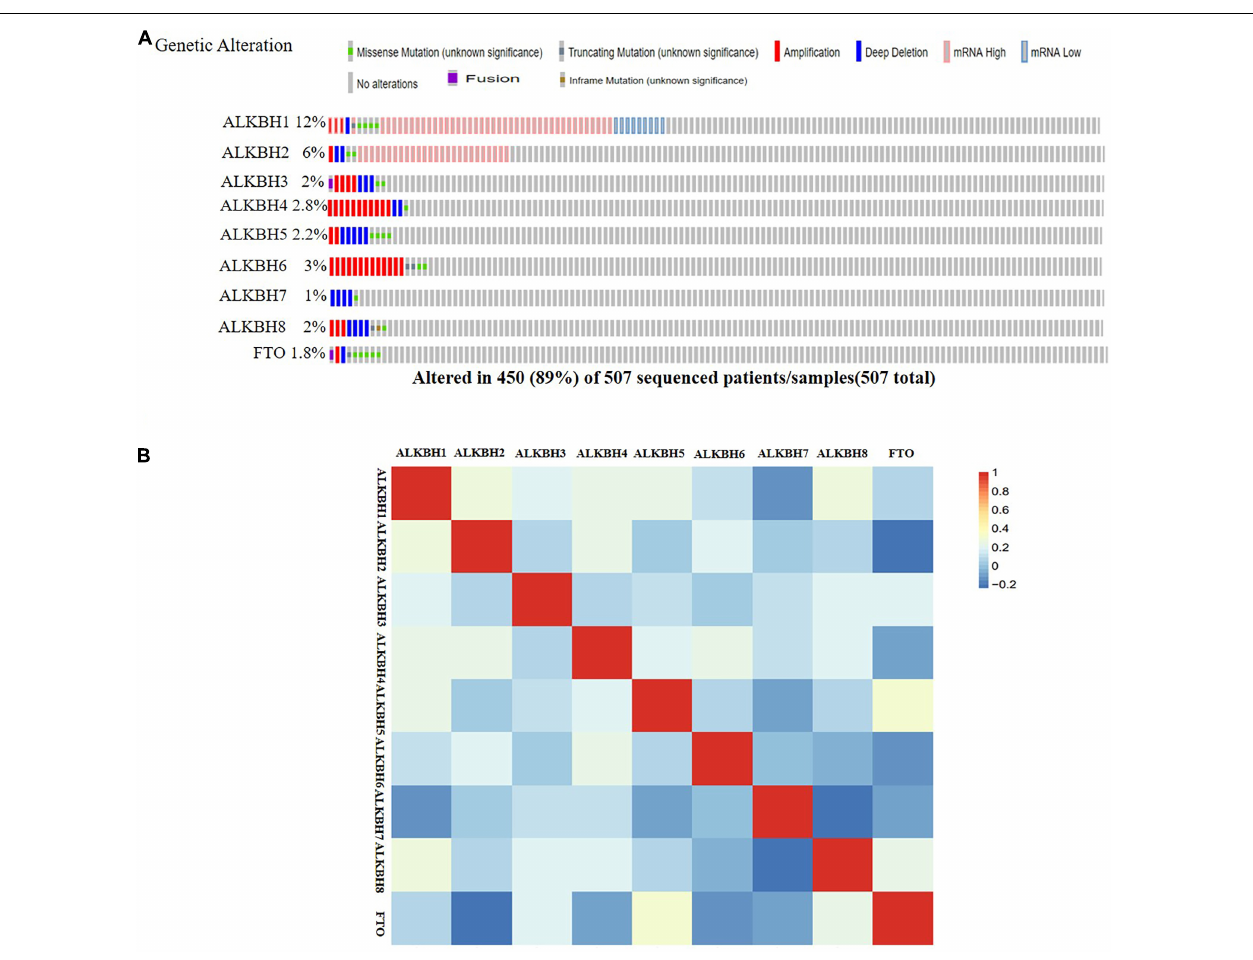
FIGURE 4 | Genetic alternatives and correlation analysis of the AlkB family in LUAD. (A) Summary of the mutation rates in each AlkB family member in LUAD. (B) Correlation between different AlkB family in LUAD